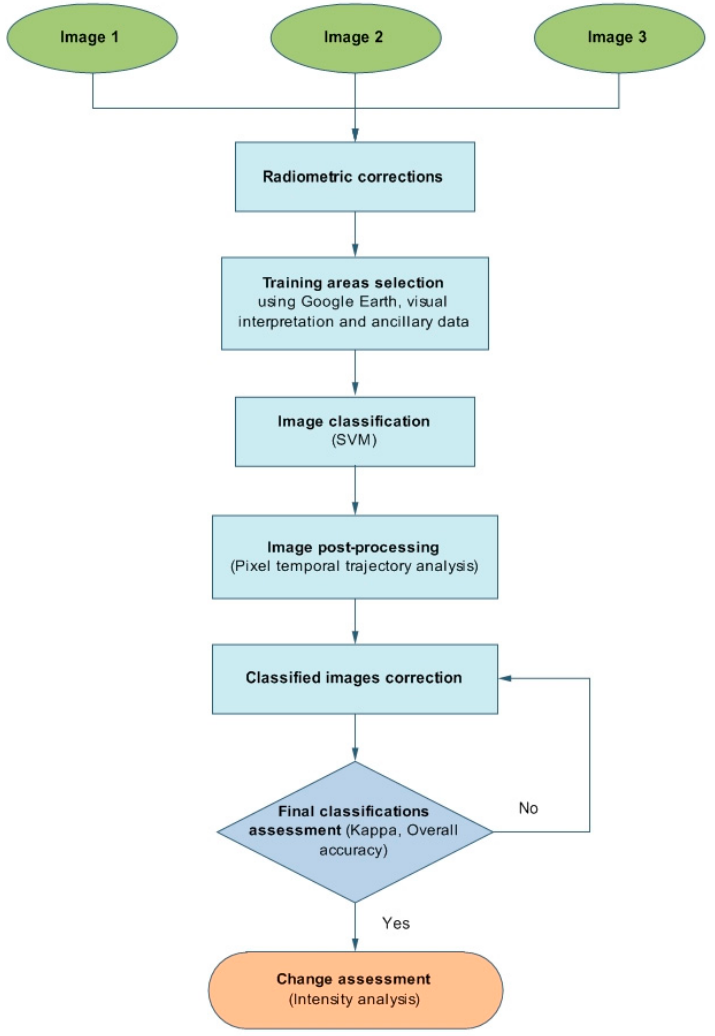
Figure 3. Flowchart of the data inputs, key procedures and data processing for mapping irrigated areas in the Mogtedo region, Burkina Faso.